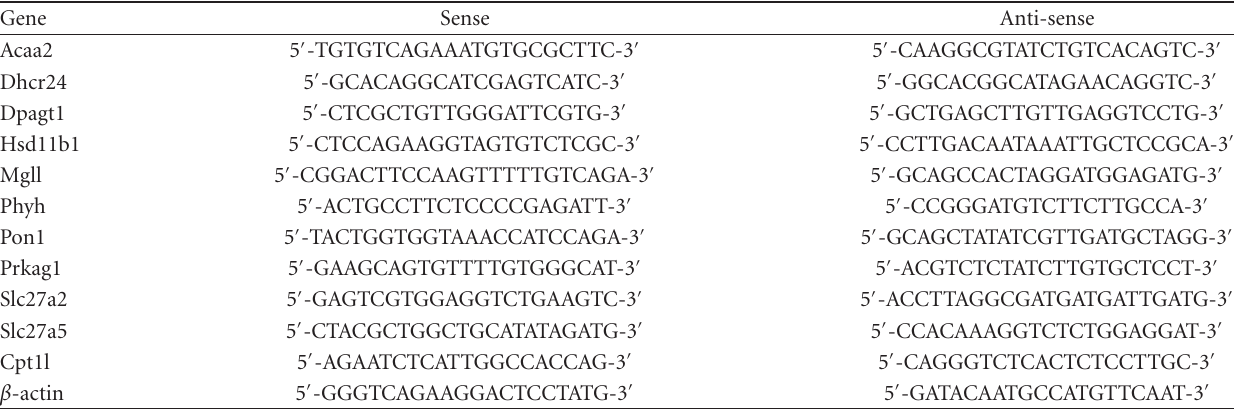
Table 2: Primers for RT-PCR.